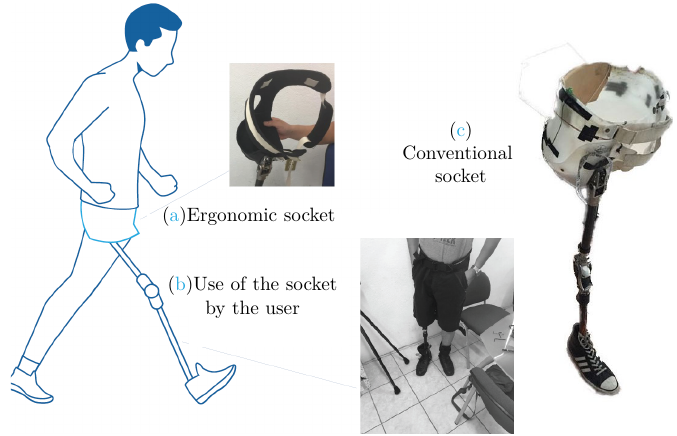
Figure 9. Final prototype and conventional